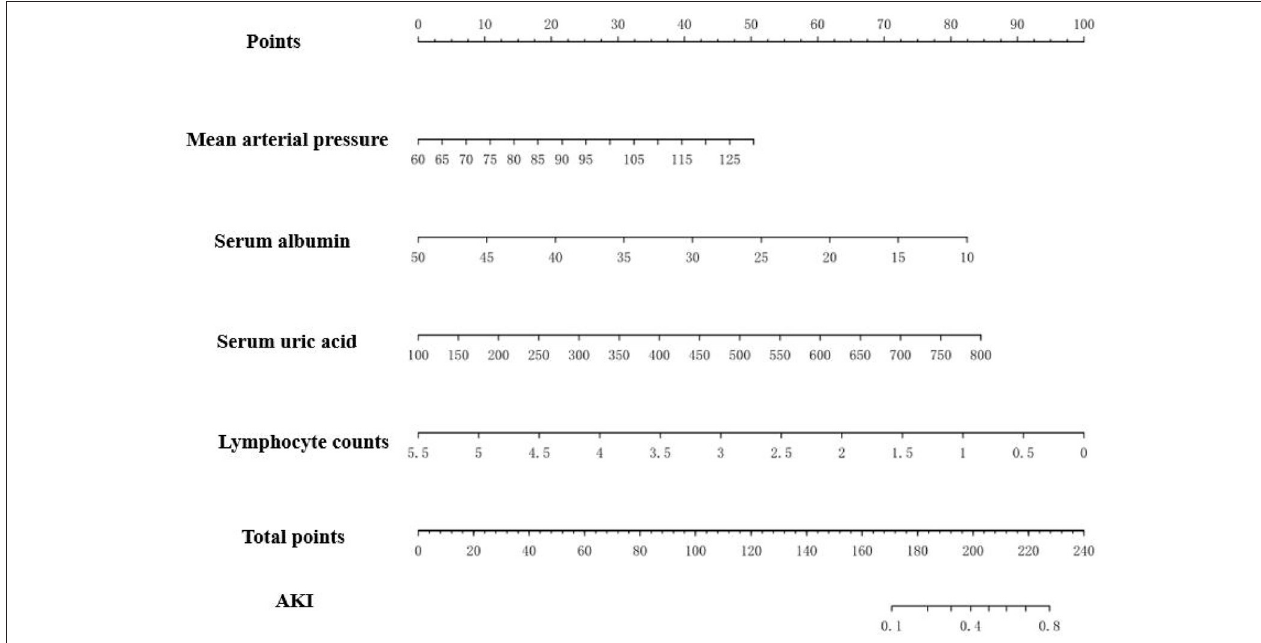
FIGURE 3 | The nomogram to estimate the risk of AKI in MCD patients. To use the nomogram, search the position of each variable on the corresponding axis, draw a line to the points axis for the number of points, add the total points, and draw a line from the total points axis to determine the AKI probabilities at the lower line of the nomogram. For example, doctor checked an MCD patient blood pressure is 120/90 mmHg, and her laboratory test revealed serum albumin 20 g/L, serum urci acid 400 µ mol/L, lymphocyte counts 2.5*10 9 /L. Based on the nomogram, her points were 29, 62, 36 and 55, respectively. The total points was 182 and the probability of AKI was 0.2.